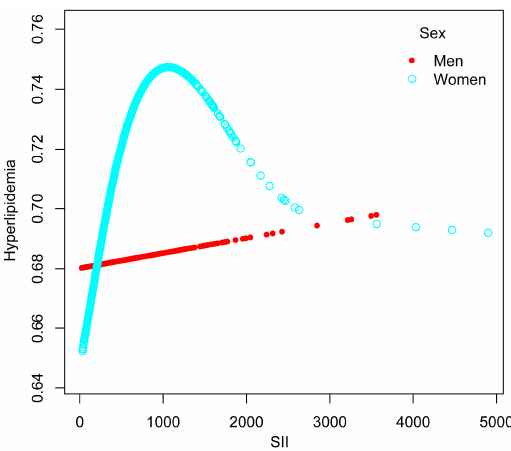
Figure 4. The association between SII and hyperlipidemia stratified by sex. Table 4. Threshold effect analysis of SII on hyperlipidemia using a linear regression model.